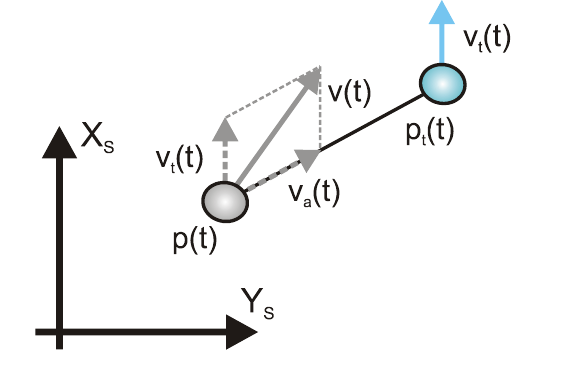
Figure 5: Interceptor speed assignment for movement along the